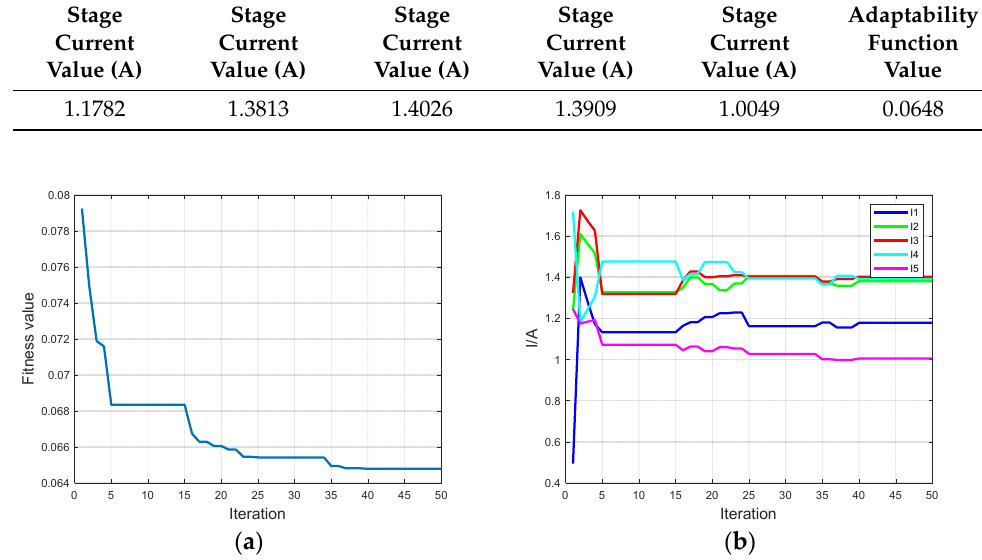
Figure 9. Five-stage constant current charging strategy optimization curve: ( a ) fitness value curve;